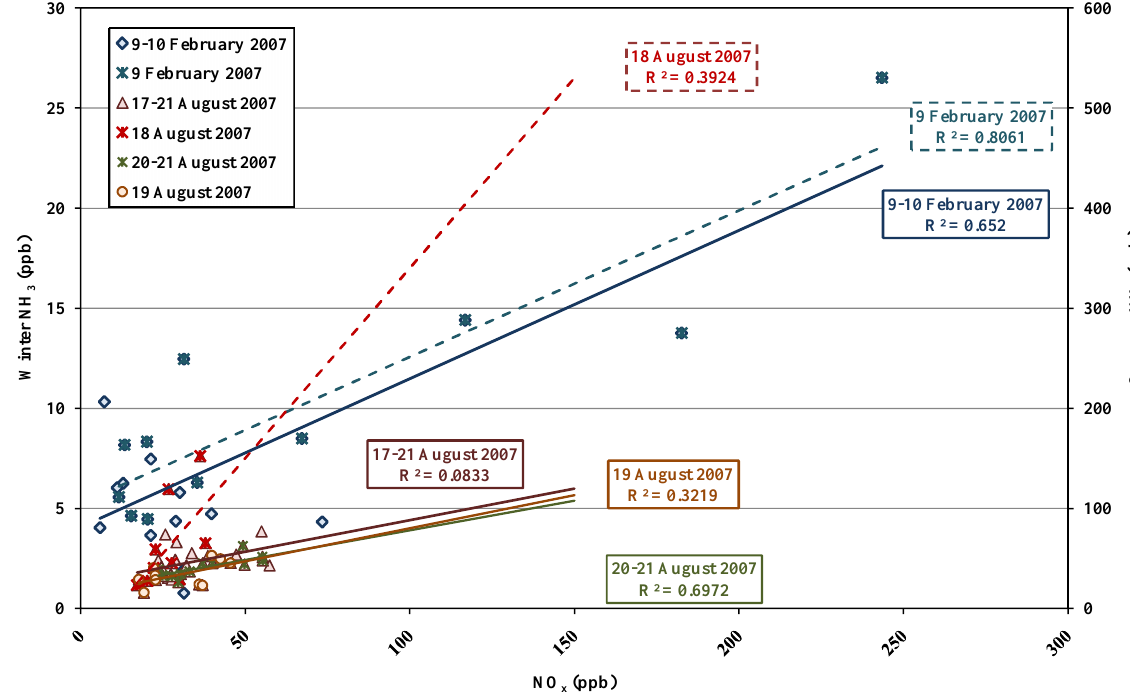
Fig. 5. Relationship between NH 3 and NO x during the intensive winter and summer